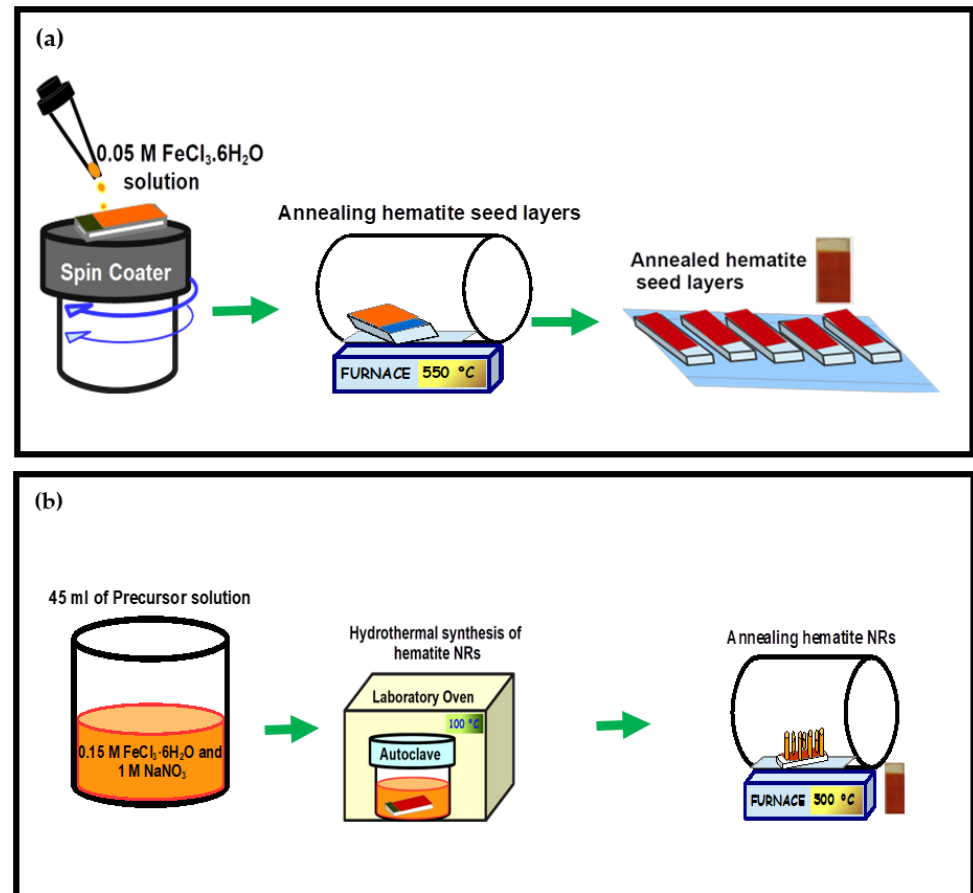
Figure 1. ( a ) Schematic illustration of the preparation of hematite seed layers on FTO by spin coating and ( b ) hydrothermal synthesis of hematite NRs.